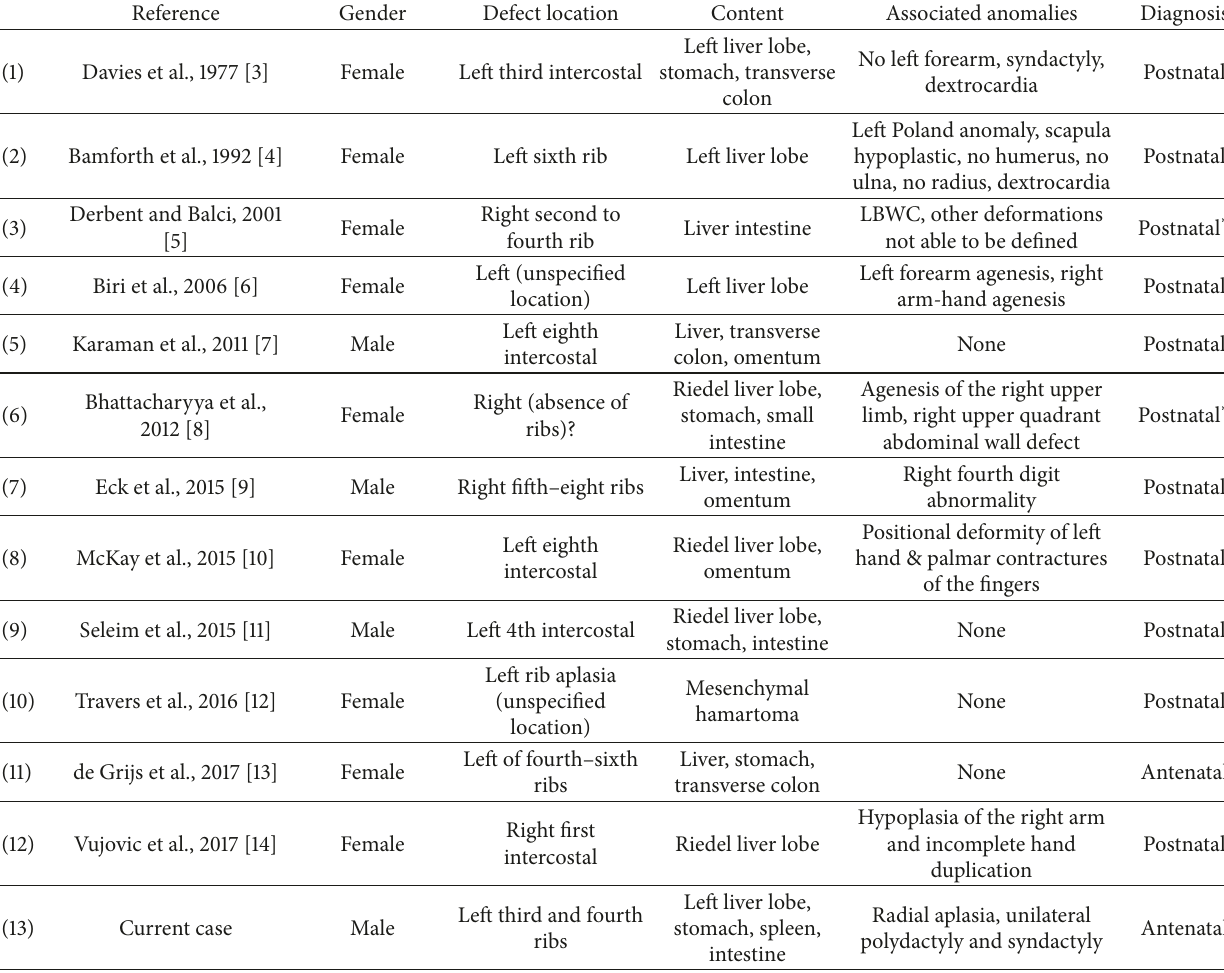
Table 1: Reported cases of thoracoschisis.